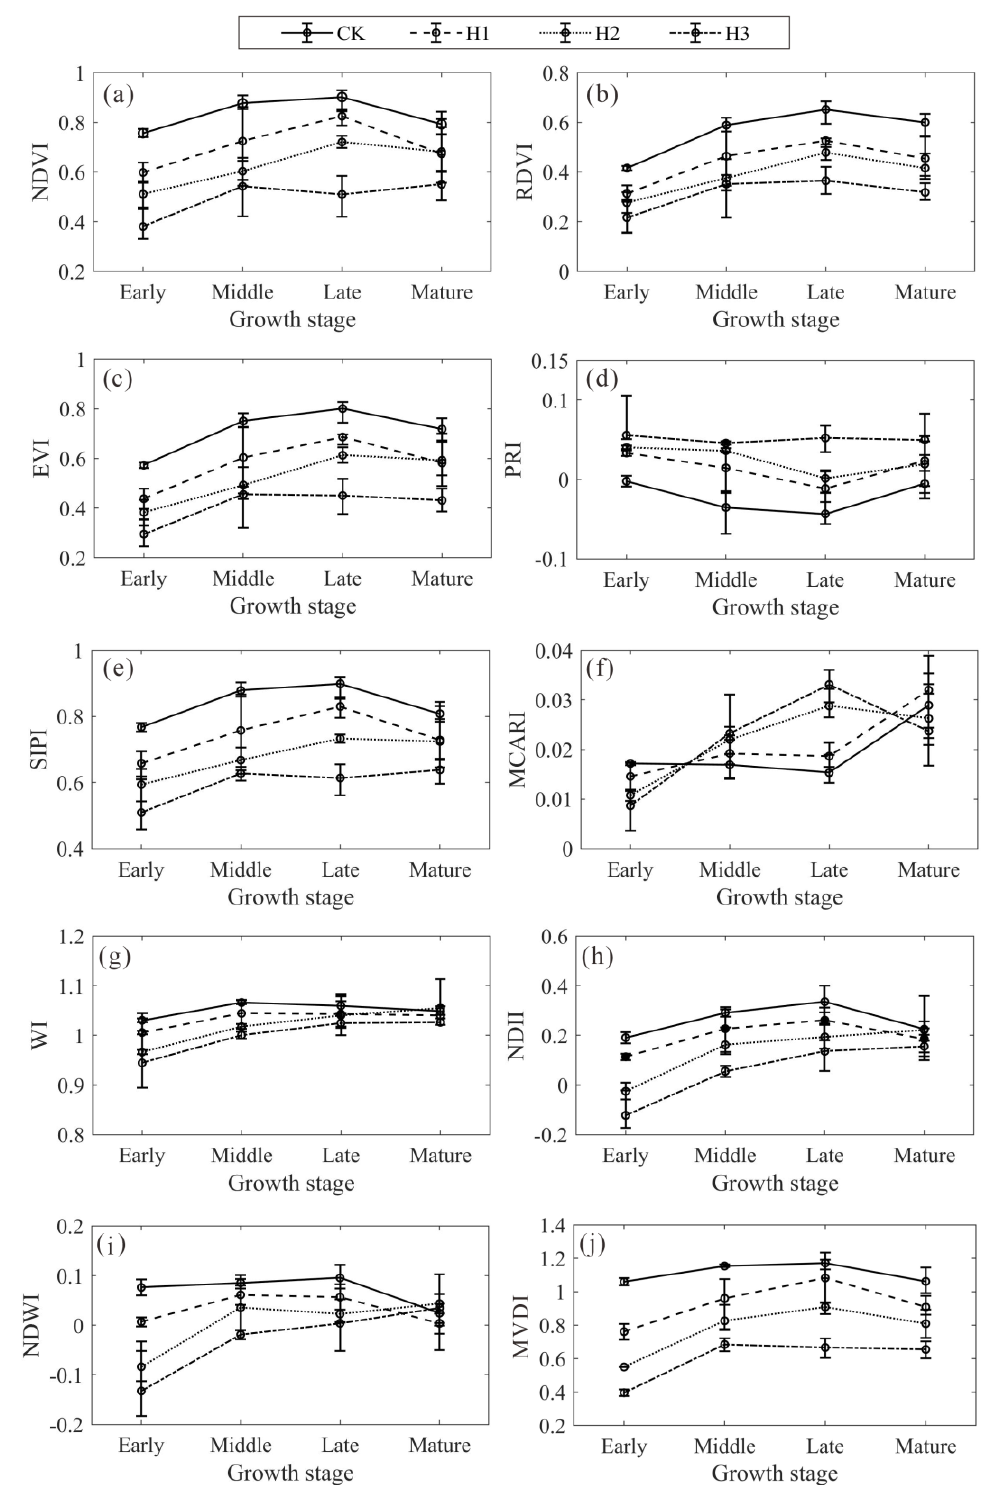
Figure 7. ( a–j ) Recognition ability of vegetation indices under different water stress levels during the main growth stage of the crop. ( a ) The NDVI; ( b ) RDVI; ( c ) EVI; ( d ) PRI; ( e ) SIPI; ( f ) MCARI; ( g ) WI; ( h ) NDII; ( i ) NDWI; and ( j ) MVDI. The four water stress levels are as follows: no water stress (N: 70–80%FC), light water stress (L: 50–60%FC), moderate water stress (M: 40–50%FC), and severe water stress (S: 30–40%FC).